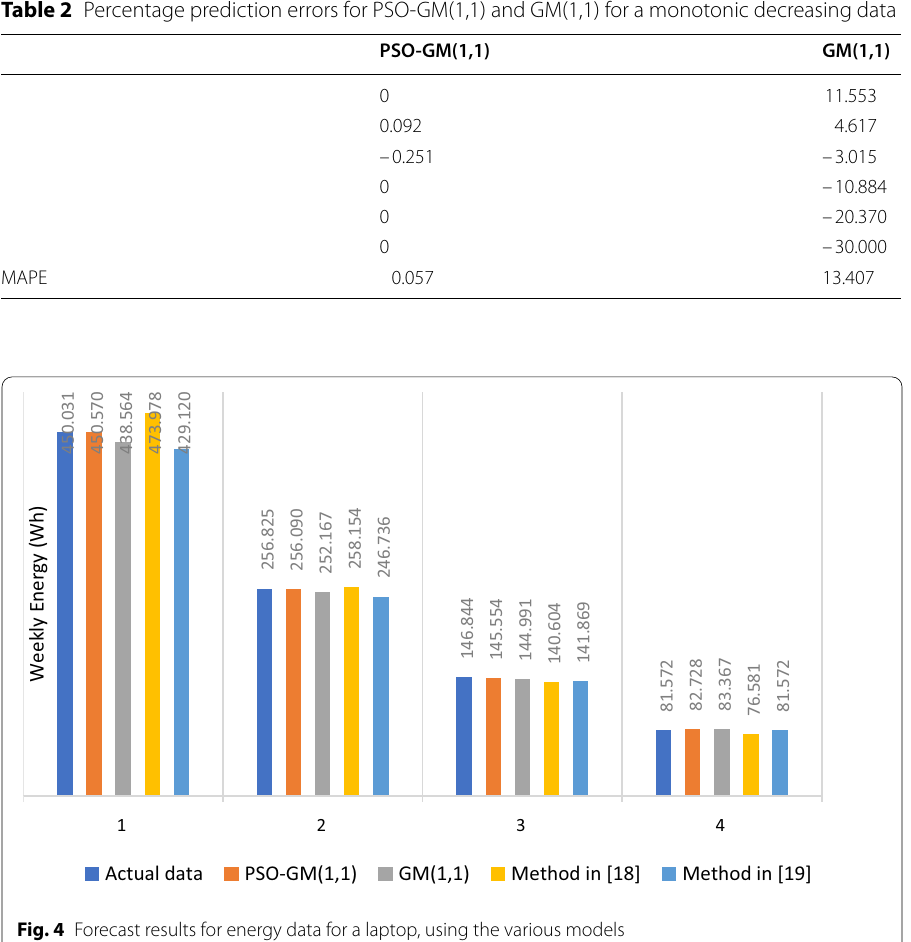
percentage error associated with the GM(1,1) is -20.37%. Table 2 shows the errors asso-